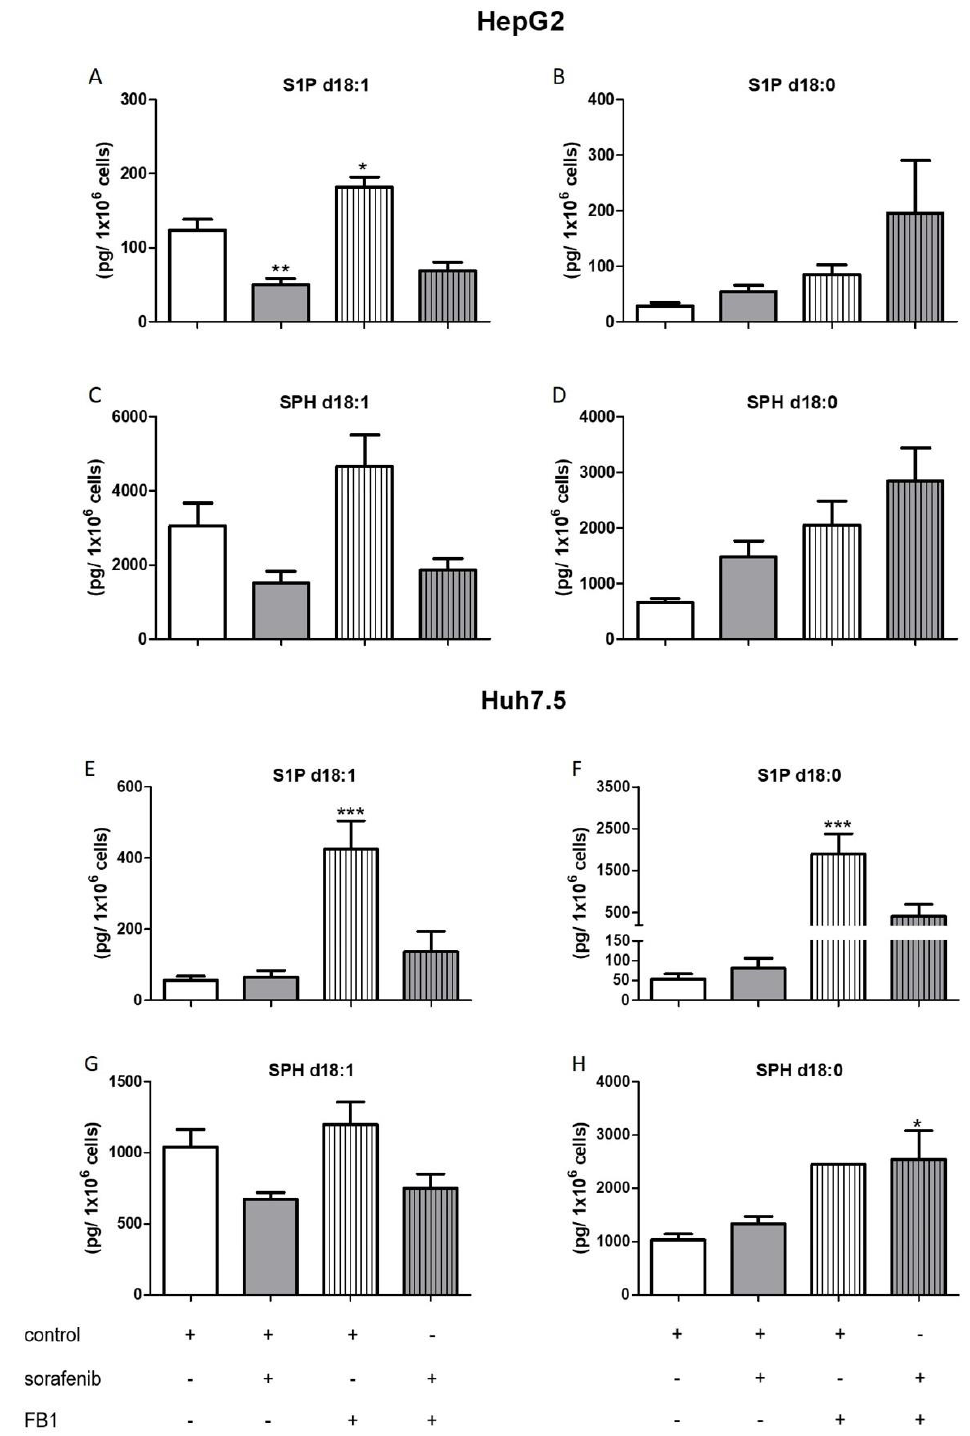
Figure 7. Influence of sorafenib and FB1 on concentrations of S1P and sphingosine in HepG2 and Huh7.5 cells. The lipids were measured by LC-MS / MS. The cells (HepG2 in ( A )–( D ) and Huh7.5 in ( E )–( H )) were treated with or without 10 µ M SKI II for 2 h before the addition of vehicle (control; 0.2% DMSO) or 5 µ M sorafenib and further incubation for 24 h. All results are presented as means ± SEM of three independent experiments. * p < 0.05, ** p < 0.01, *** p < 0.001 compared to control in one-way ANOVA followed by Bonferroni post-tests. For SPH d18:0 in Huh7.5 cells treated with FB1, only one experiment could be